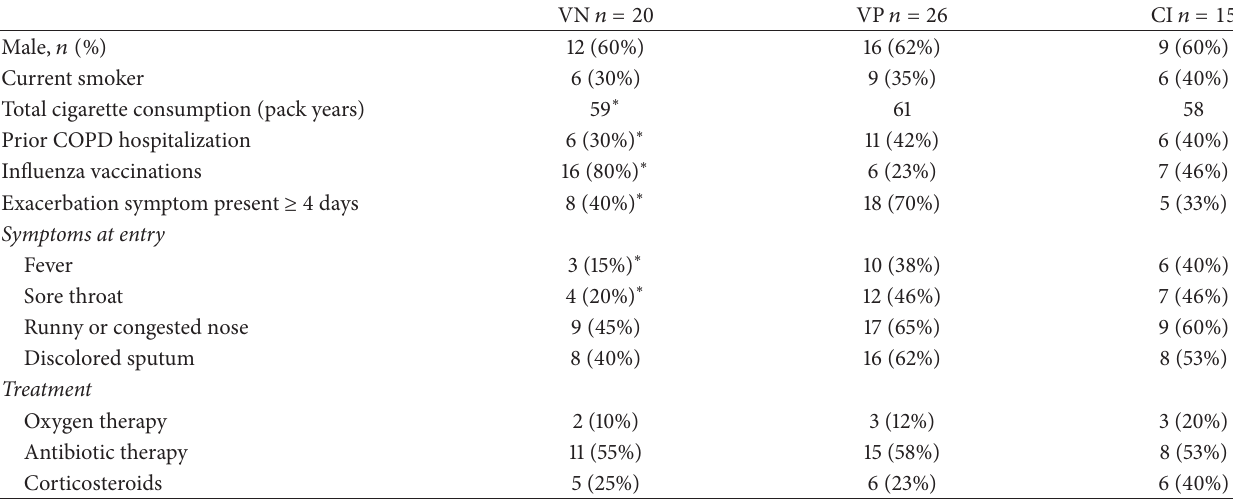
Table 3: Baseline characteristics according to viral status.